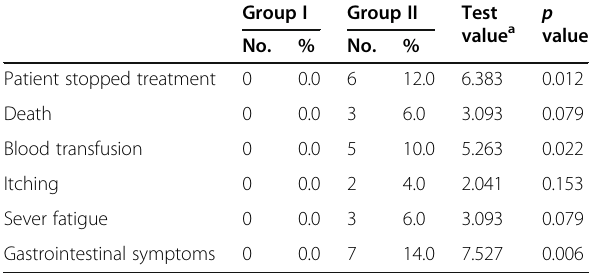
Table 2 Comparison between group I (control group) and group II (case group) regarding complications occurred during the course of